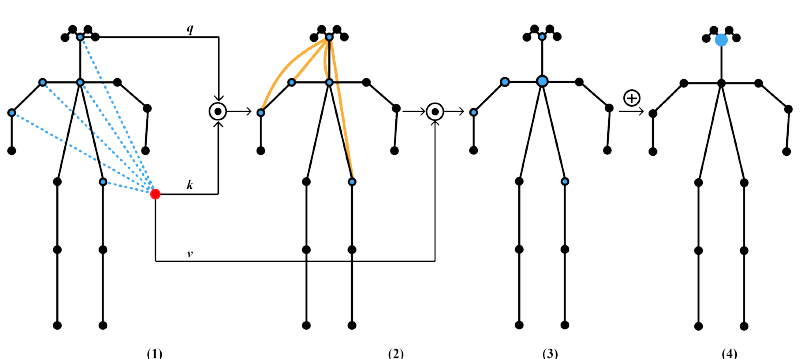
Figure 5. Self-attention of skeleton joints. ( 1 ) We calculate a query q a key k and a value vector v ; ( 2 ) The query of the joint and the key of all the other joints is performed by dot product ( (cid:12) ), and a weighted value is obtained to represent the strength of the connection between each pair of joints; ( 3 ) Each joint is scaled to a new node due to its correlation; ( 4 ) The new features are added ( ⊕ ) the weighted nodes